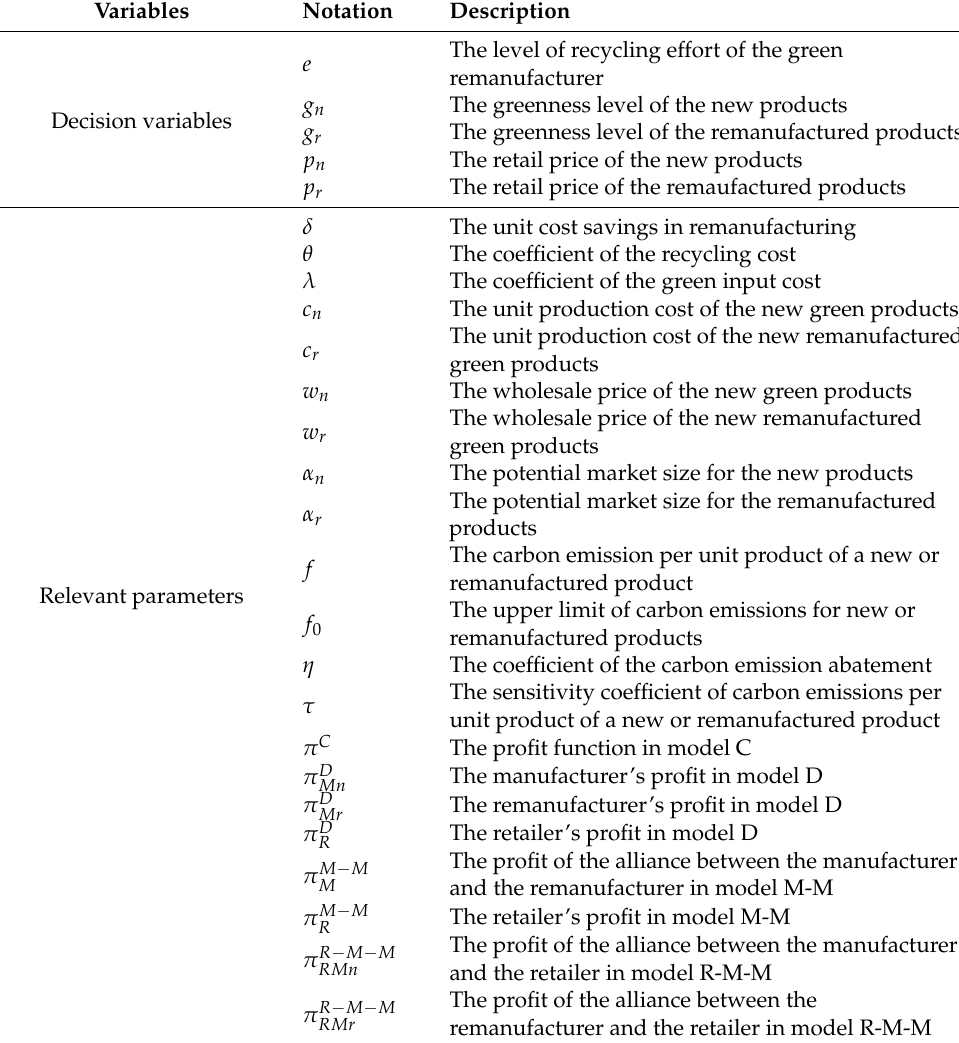
Table 2. Description of the relevant